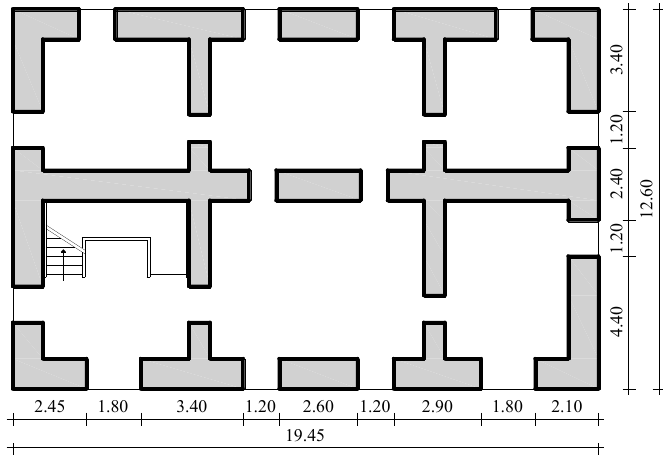
Figure 2. Typical floor plan of case-study building (dimensions in